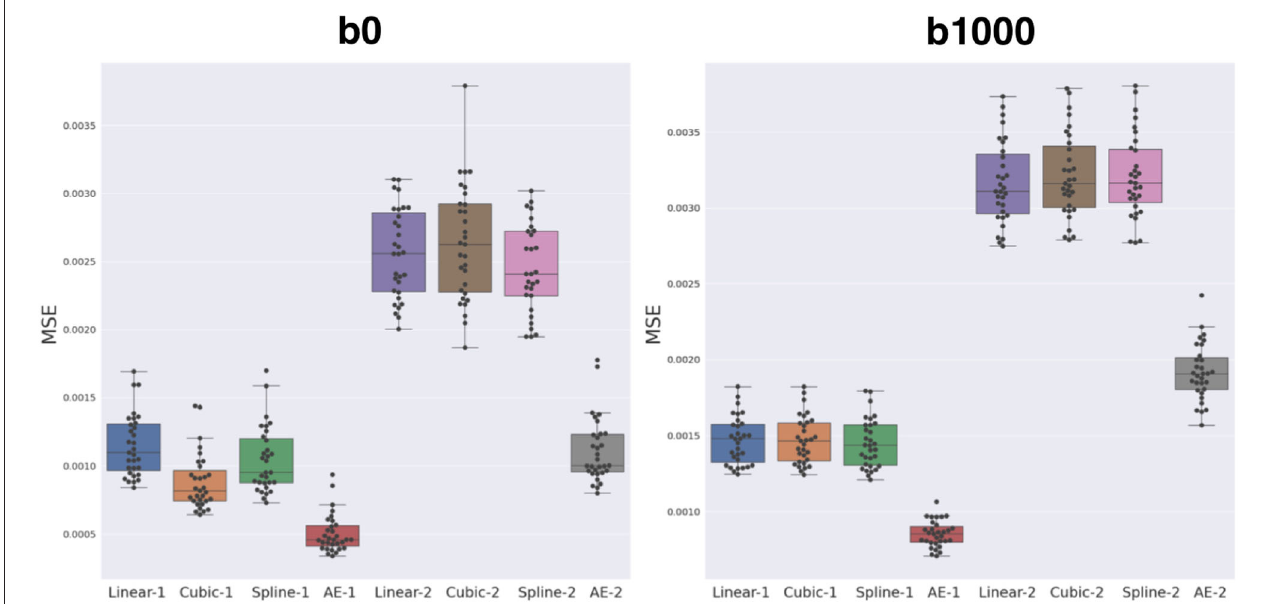
FIGURE 5 | Mean squared error (MSE) between the three baseline methods (linear, cubic, and B-spline 5 th order) and autoencoder (AE) enhancement both for b0 (left) and b1000 (right). Two configurations were assessed: either N = 1, i.e., removing one slice and interpolating/synthesizing it (Linear-1, Cubic-1, Spline-1, AE-1) or N =